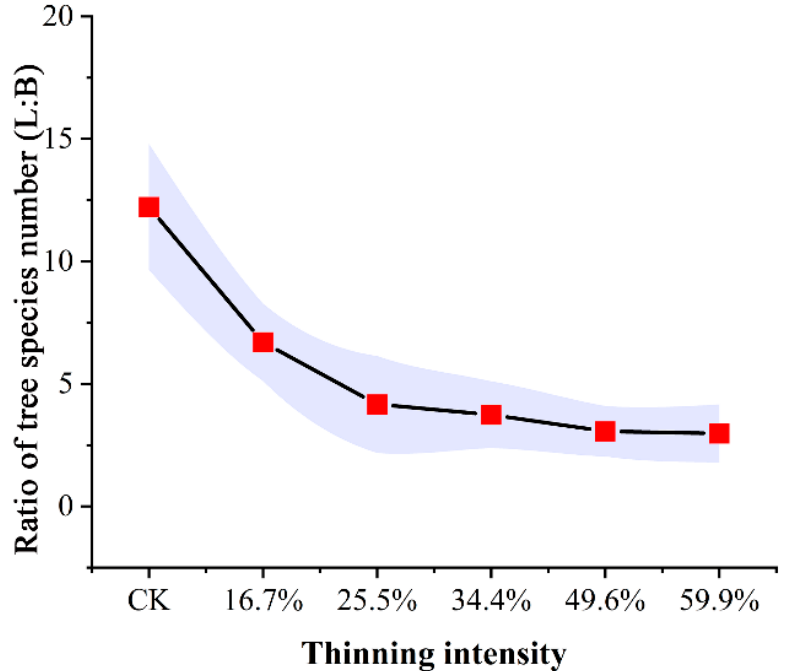
Figure 3. Proportion of tree species number in sample plots (L: larch; B: birch). As shown in Figure 3, the ratio of larch to birch in thinned plots was much smaller than that in CK plot. As the thinning intensity increases, the ratio of larch to birch decreased rapidly at first and then decreased slowly, finally becoming stable. Generally speaking, in all thinned groups, the proportion of larch decreased compared to the CK group. These plots were replaced by the pioneering, light-loving, fast-growing species of birch. The results showed that thinning directly caused the decline in larch population and